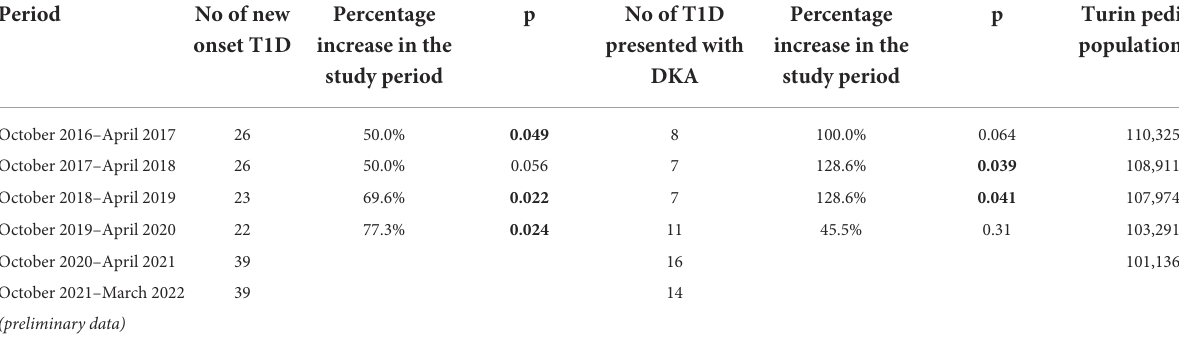
TABLE 1 Number of annual newly diagnosed T1D and DKA from 2016 to 2022. Period No of new